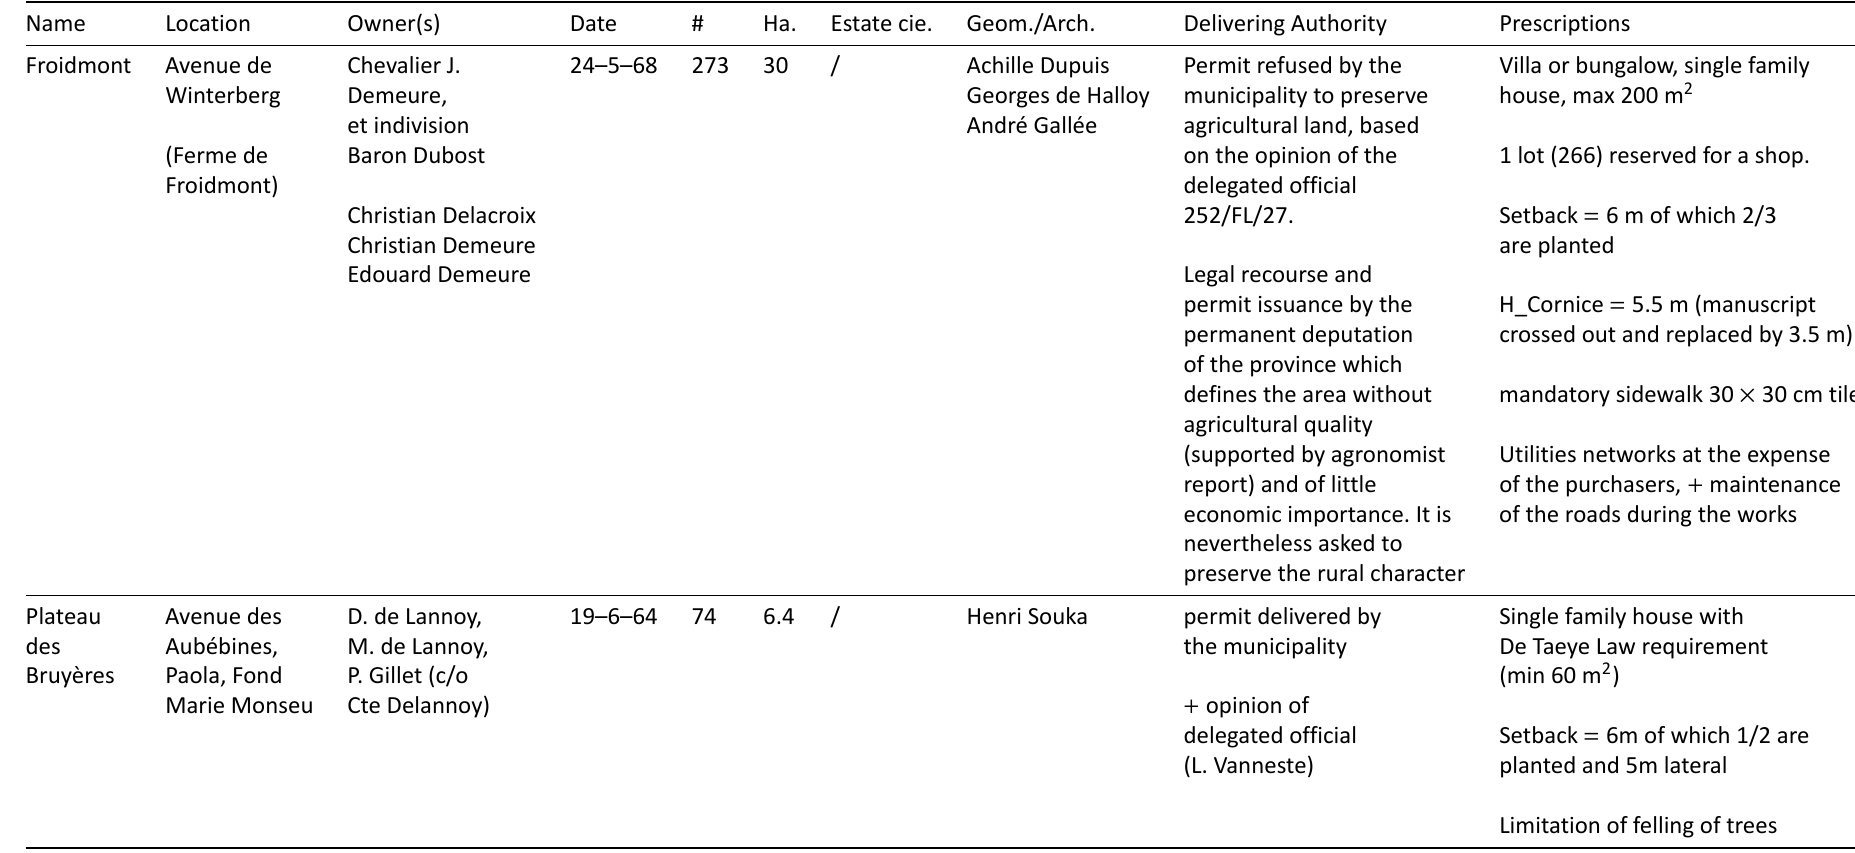
Table 2. (Cont.) Selection of allotments in Rixensart.